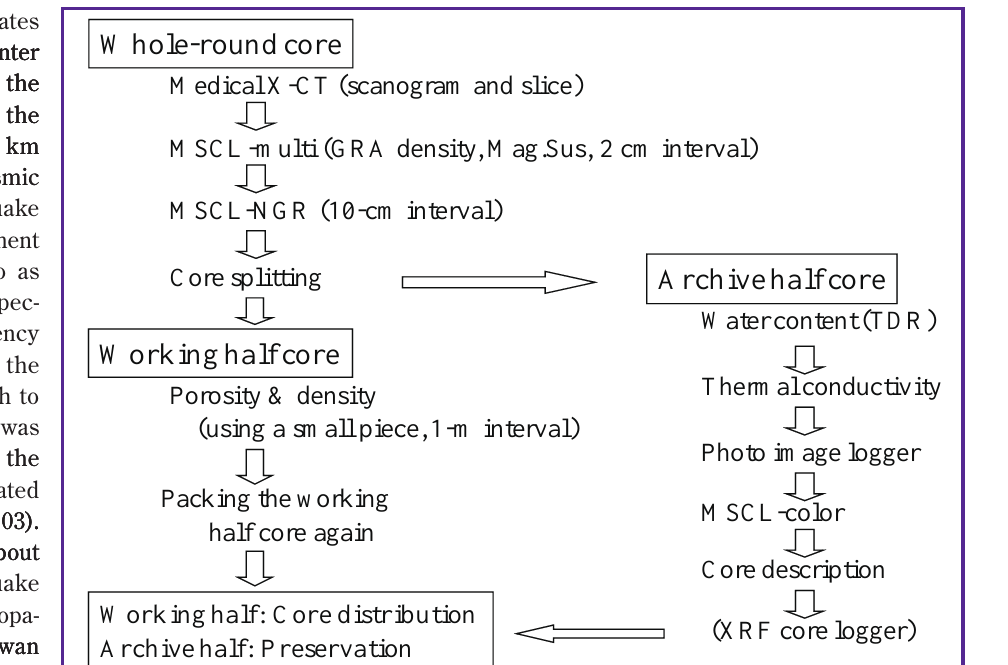
Figure 1. Flow of the non-destructive measurements using all the core samples taken from Hole B, TCDP. MSCL: Multi sensor core logger; GRA: gamma ray attenuation; NGR: natural gamma ray; TDR: time domain reflectometry; XRF: x-ray